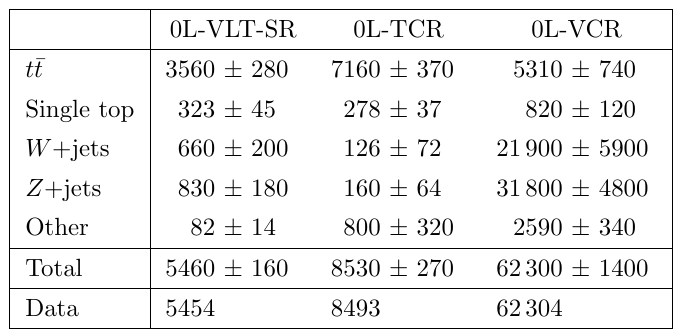
Table 6 . Numbers of events observed in the signal and control regions used for the resonant dark-matter search, together with the estimated SM backgrounds in the (cid:12)t to data, under the background-only hypothesis. The uncertainties include statistical and systematic uncertainties. The uncertainties in the individual backgrounds are correlated, and do not necessarily add in quadrature to the total background uncertainty.